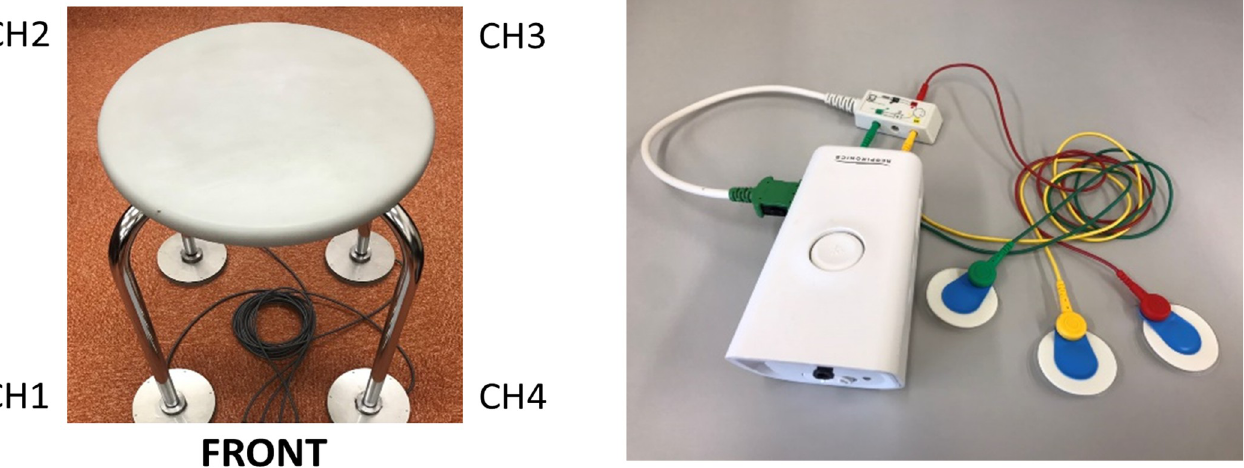
PLOS ONE | https://doi.org/10.1371/journal.pone.0272072 July 29,